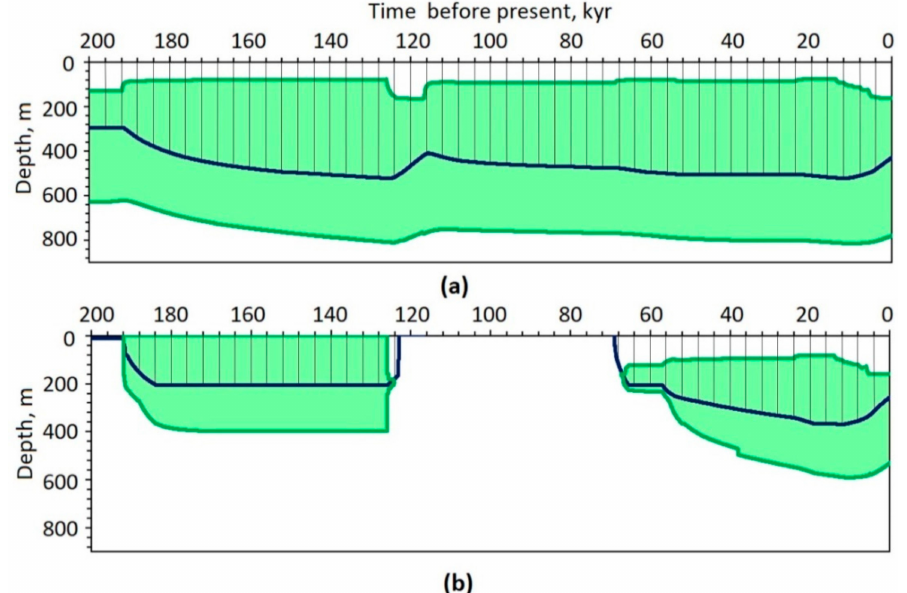
Figure 10. Permafrost and GHSZ evolution under the extraglacial ( a ) and glacial conditions ( b ) on 5 m isobaths with the heat flux of 60 mW / m 2 . Permafrost—shaded area; GHSZ—green